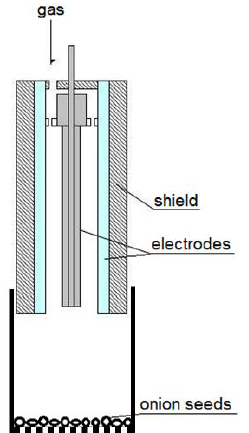
Figure 1. Schema of experimental set up with radio frequency atmospheric pressure plasma jet.